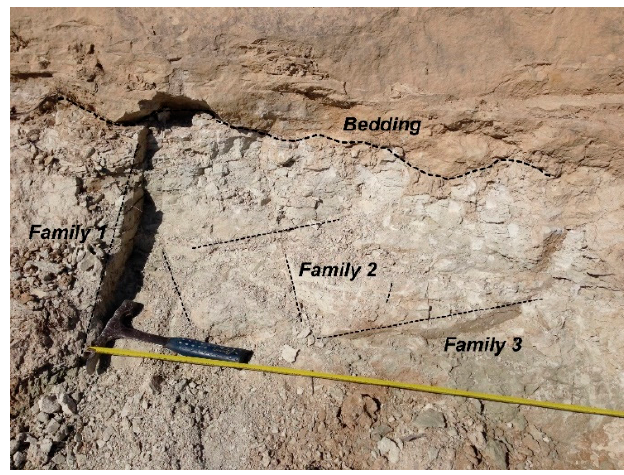
Figure 3. Discontinuities identified in the outcrop.